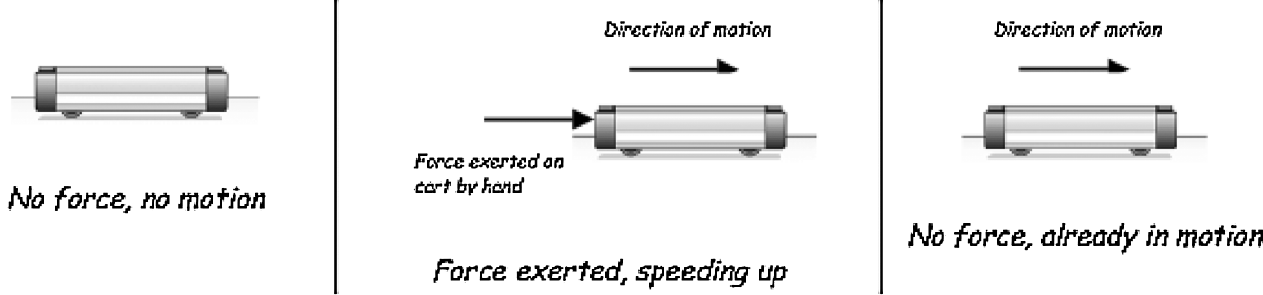
FIG. 4. Force diagrams corresponding to the energy diagrams in Fig.